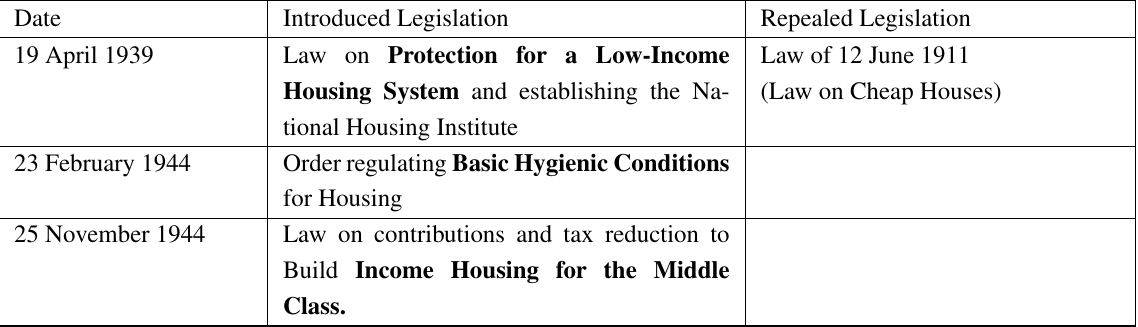
Table 1. Main Legislation on Social Housing during Franco´s Government. 1939